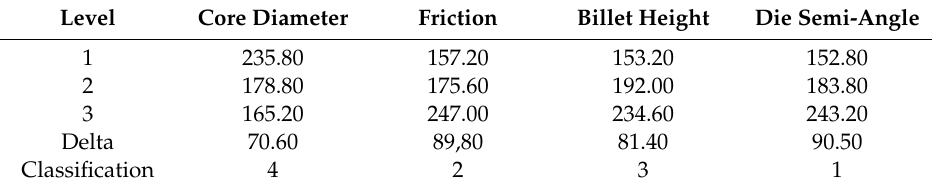
Table 13. Taguchi’s results for the average values for extrusion force (kN).